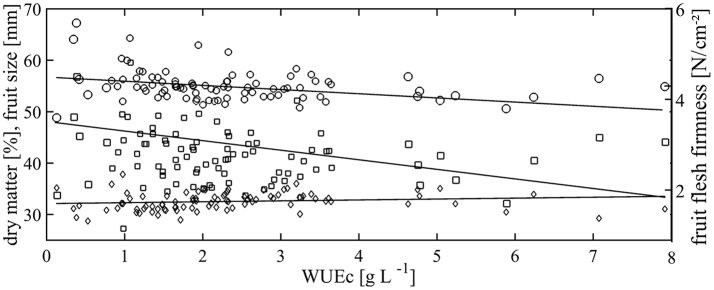
Regression analyses of data (means per tree; n = 88) of fruit dry matter (diamonds, y = 5.903x1 + 34.67), fruit size (circles, y = −80.17x2 + 24.29), fruit flesh firmness (squares, y = −0.129x3 + 3.017), and cumulative water use efficiency (WUEc). Increased symbol size represents cold and hot spots.